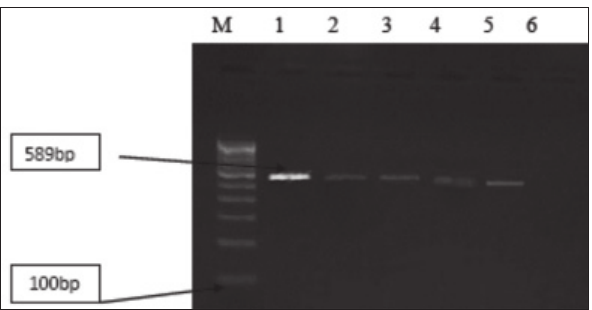
Agarose gel showing polymerase chain reaction amplified product at (589 bp) for mapA genes in Campylobacter isolates. M: Molecular marker (100 bp, Fermentas); Lane 1: Positive control; Lane 2-5: Positive samples; Lane 6: Negative control